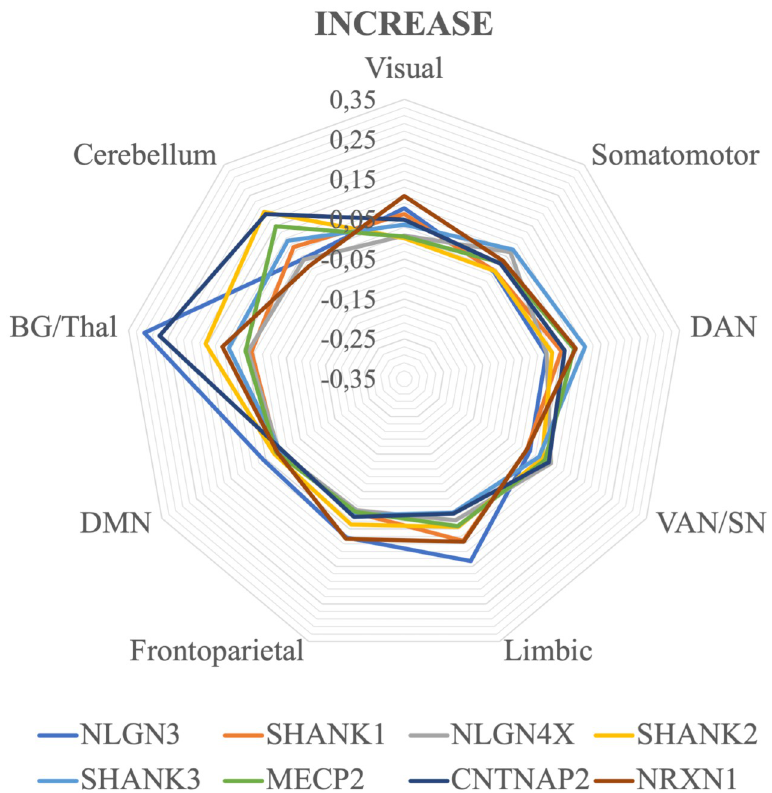
Fig 4. Average correlation between genetic expression and gray matter increases values for each gene and functional network. The maps are visualized as three-dimensional cortical and cerebellar surfaces. Brain templates are in neurological convention (i.e. R is right, L is left). Color maps represent the correlation values for each gene expression selected. Both significant and non-significant values are represented. SMN: Sensorimotor Network, DAN: